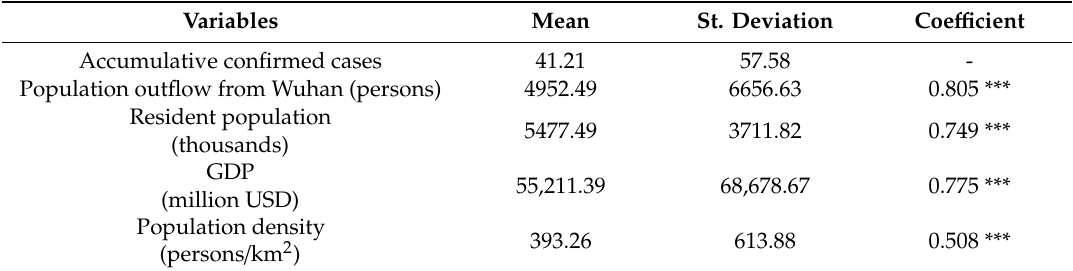
Table 2. Descriptive statistics of population outflow and other socioeconomic variables and their relationships with cumulative confirmed COVID-19 cases.